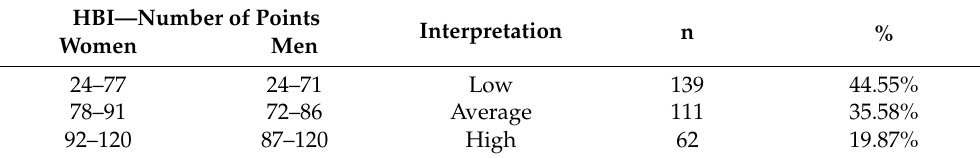
Table 2. A comparison between HBI scores. HBI—Number of